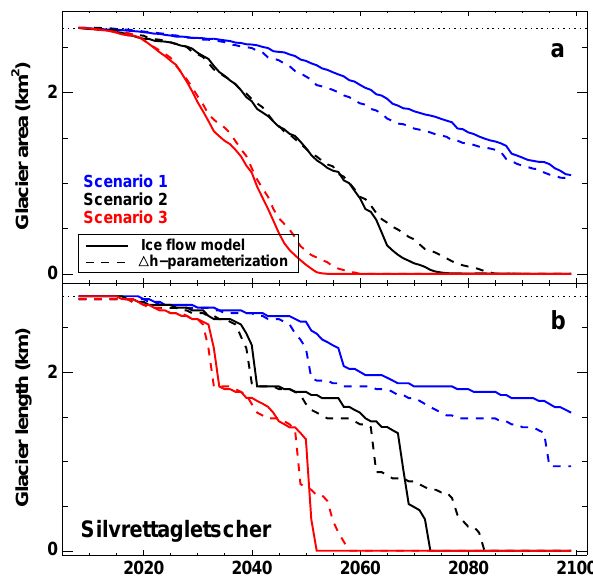
Fig. 11. Calculated (a) glacier area and (b) length based on the ice flow model and the ∆ h -parameterization according to the three climate scenarios (Silvrettagletscher).